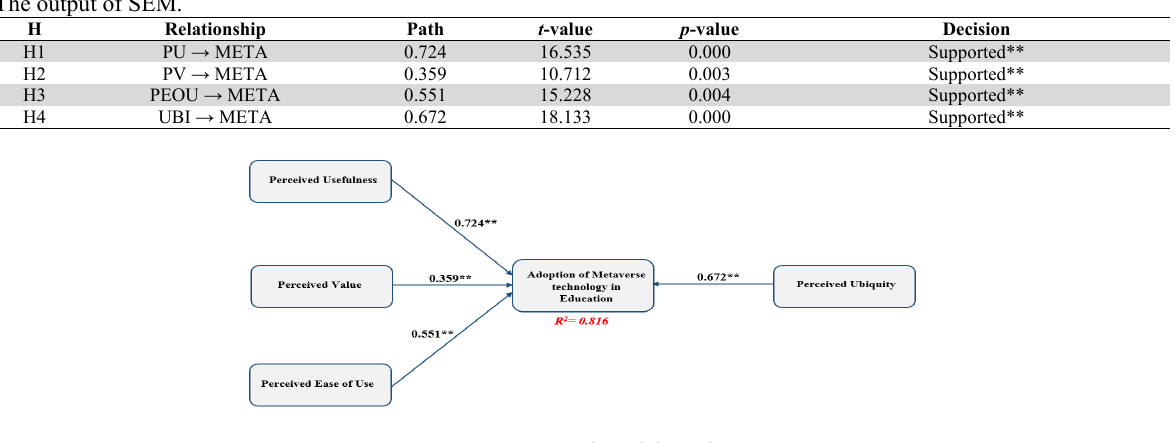
Fig. 2. Structural model results